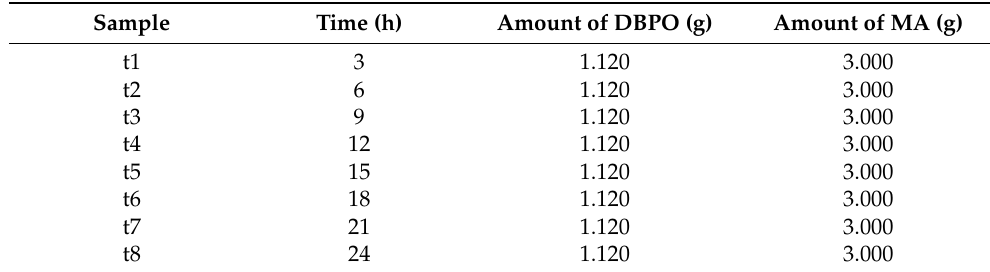
Table 1. Experimental design for the factor of stirring time.